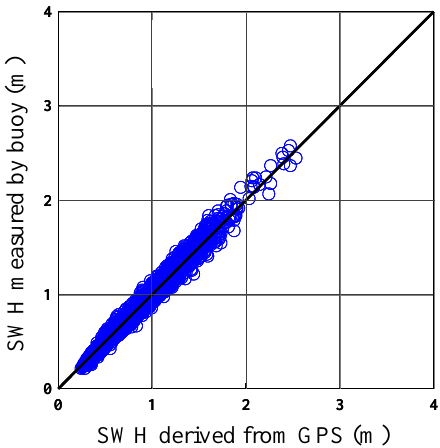
Figure 14. Comparison of significant wave height (SWH) between the buoy-measured with